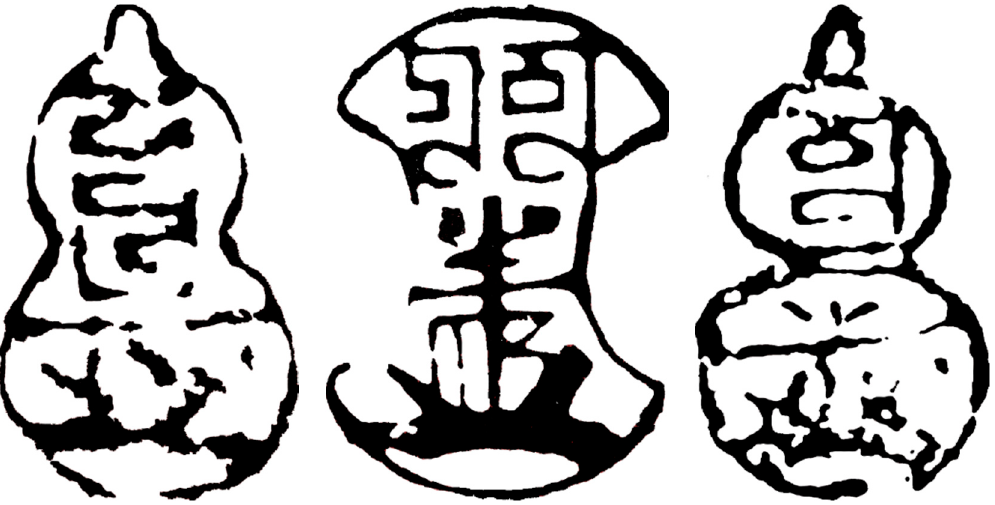
Figure 28. The Song Yuan Huaya in free style with two short lines. The Yuan Dynasty. Sketched by author. Picture source: Shi (1995), pp. 46, 52, 60.